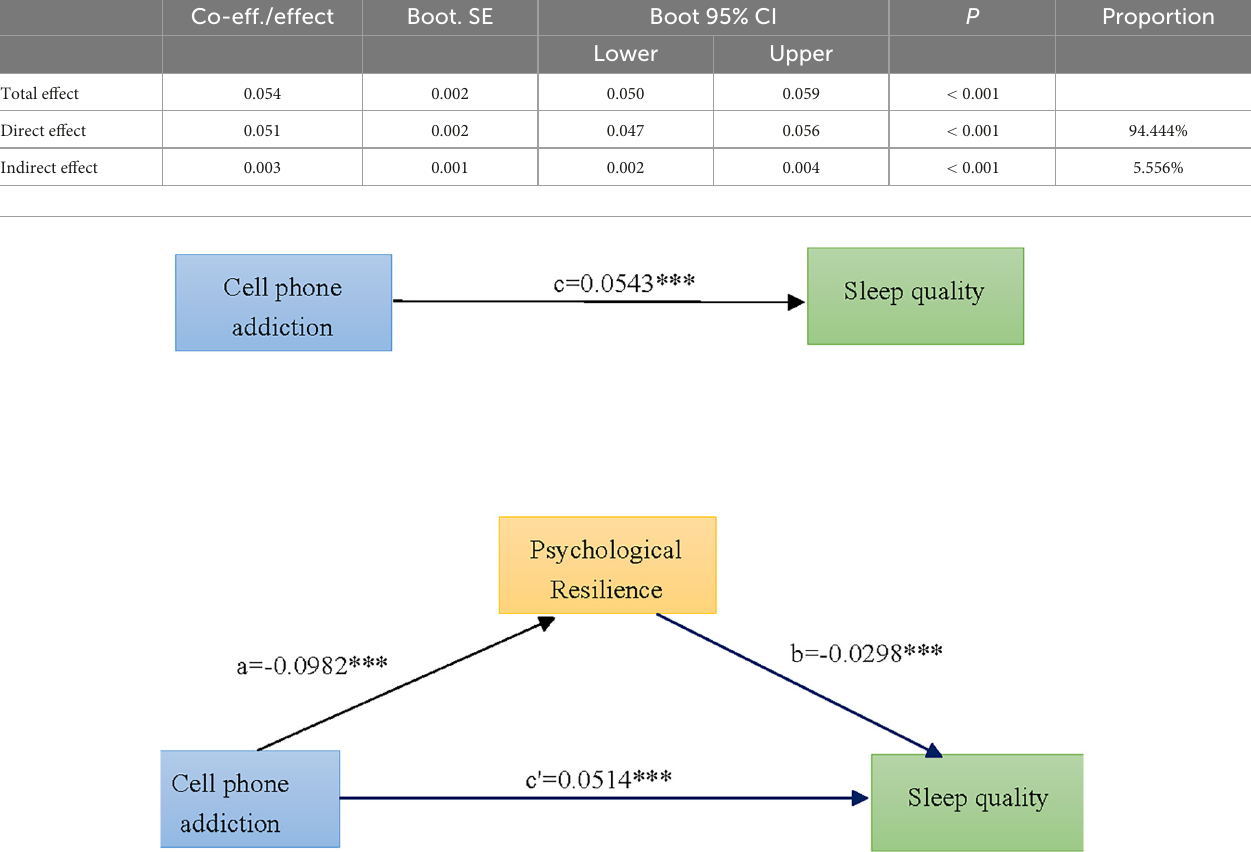
TABLE 6 Mediating effect test of psychological flexibility between cell phone addiction and sleep quality among college students. Co-eff./effect Boot. SE